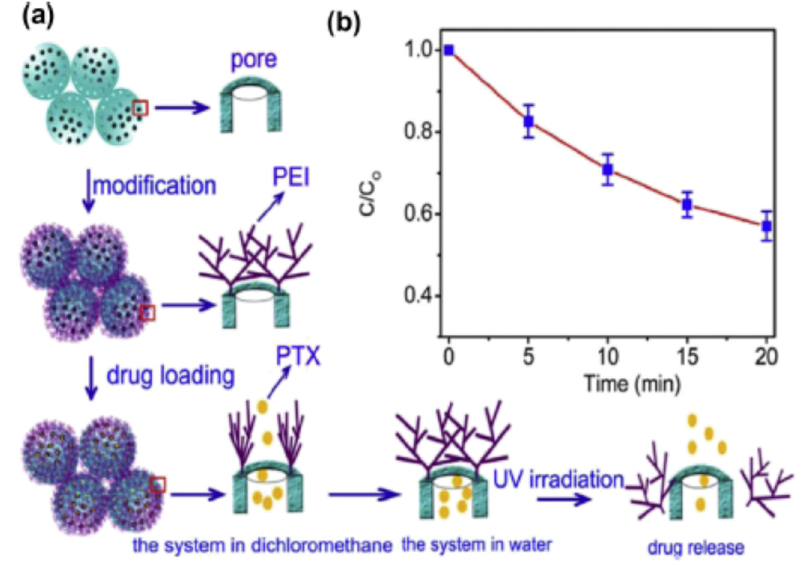
Figure 10: ( a ) Schematic sketch of stimuli drug loading and release. ( b ) The photocatalytic degradation of the FA - PEI on the surface of modi fi ed porous TiO 2 nanoparticles ( MTNP ) . Reproduced from ref. [ 145 ] with permission of